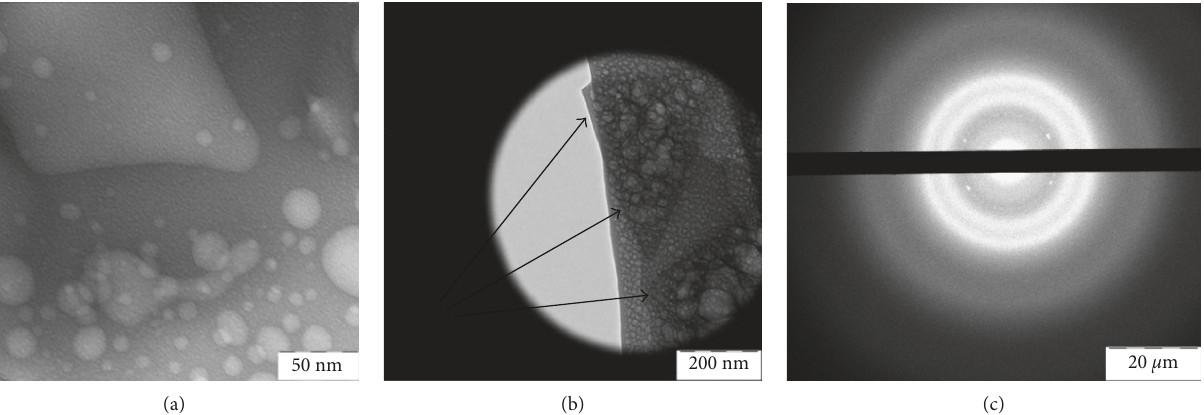
Figure 3: TEM images of (a) the organic dispersed (Gr 0 ) phase in the DMOA-aqua colloid consisted of droplets with partial dark coating and (b) the thick sheets, inside of which the cavities from dispersed phase droplets were kept. (c) Electron diffraction pattern.